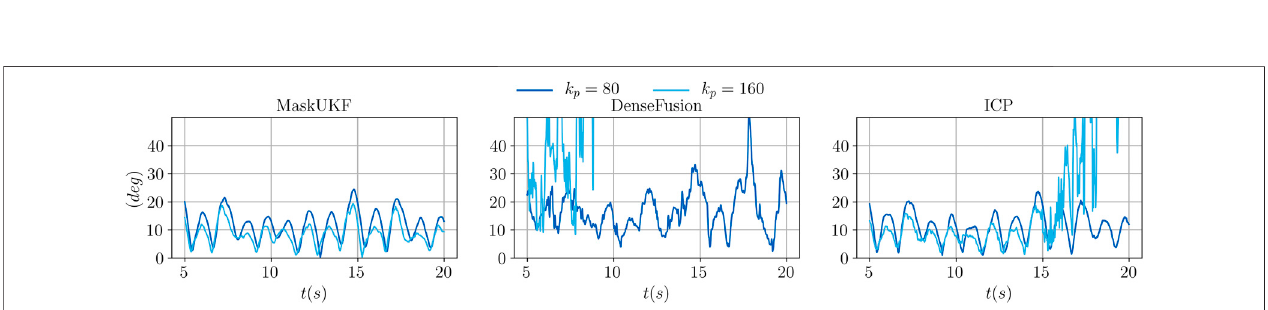
FIGURE 9 | Evolution of the angular error of the end-effector for several algorithms and different proportional gains.